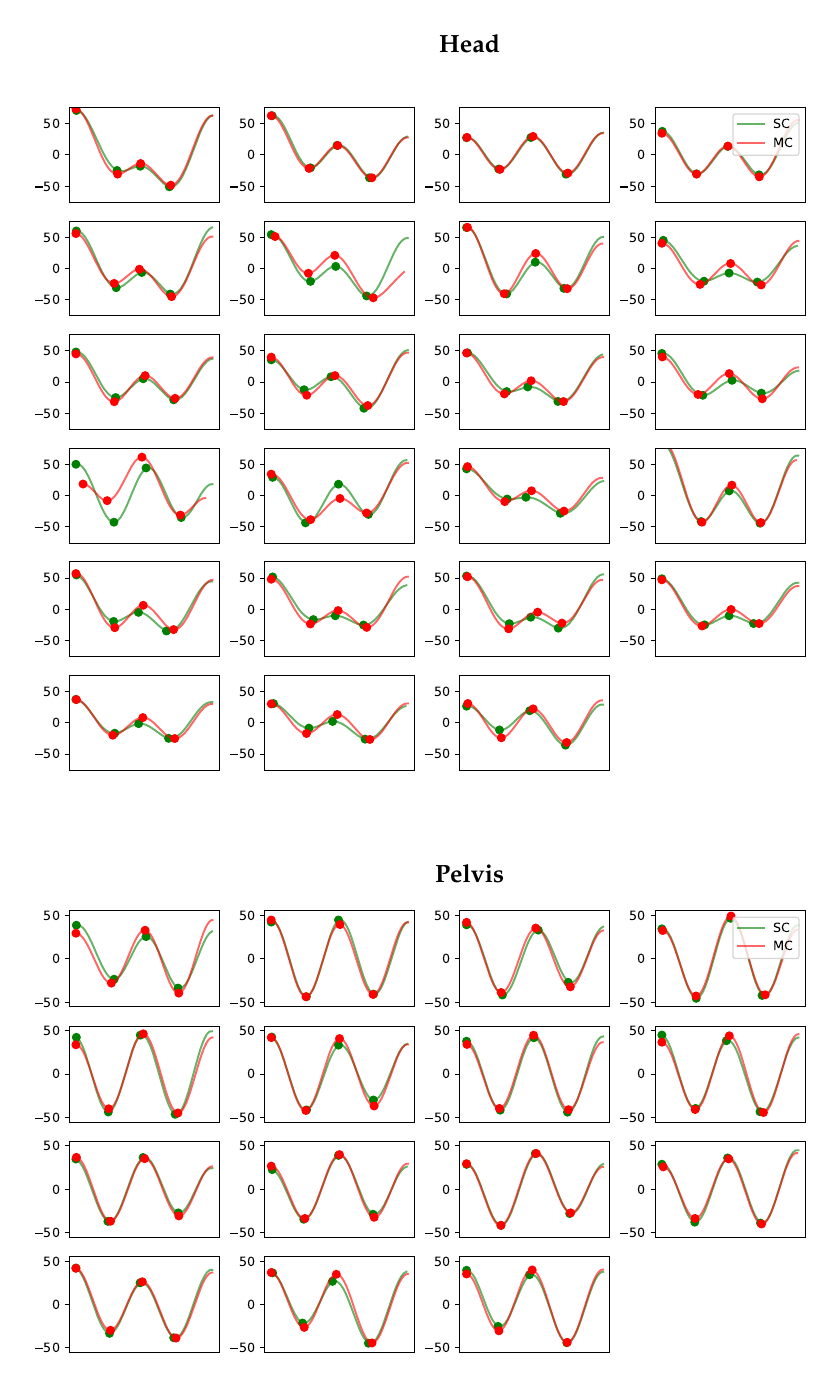
Figure A2. Vertical displacement signals per stride for the head and pelvis for horse 2. Each subplot contains the matched stride segments the single-camera markerless system (SC) in green and the multi-camera marker-based system (MC) in red. The y-axis shows the vertical displacement in millimeters. The four dots on each curve indicate the positions of the two peaks and two valleys extracted using the approach in Section